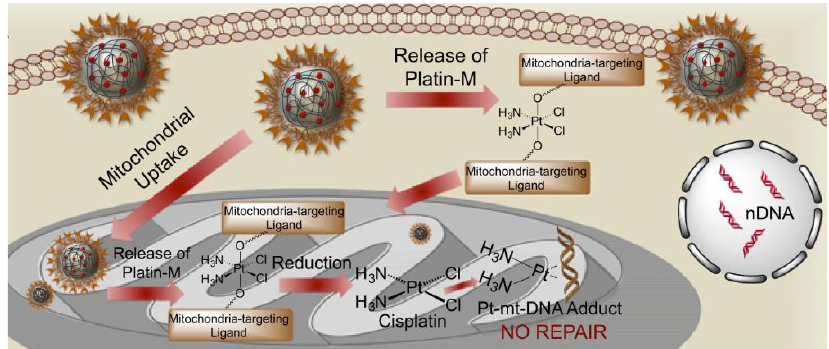
Figure 21. Mechanism of the release of Platin-M. (Reprinted from ref. [87] under the CC BY-NC-ND license, 2014).